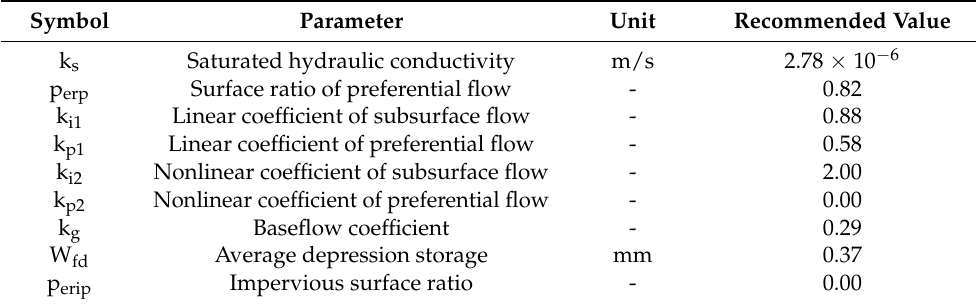
Table 1. Parameter value.